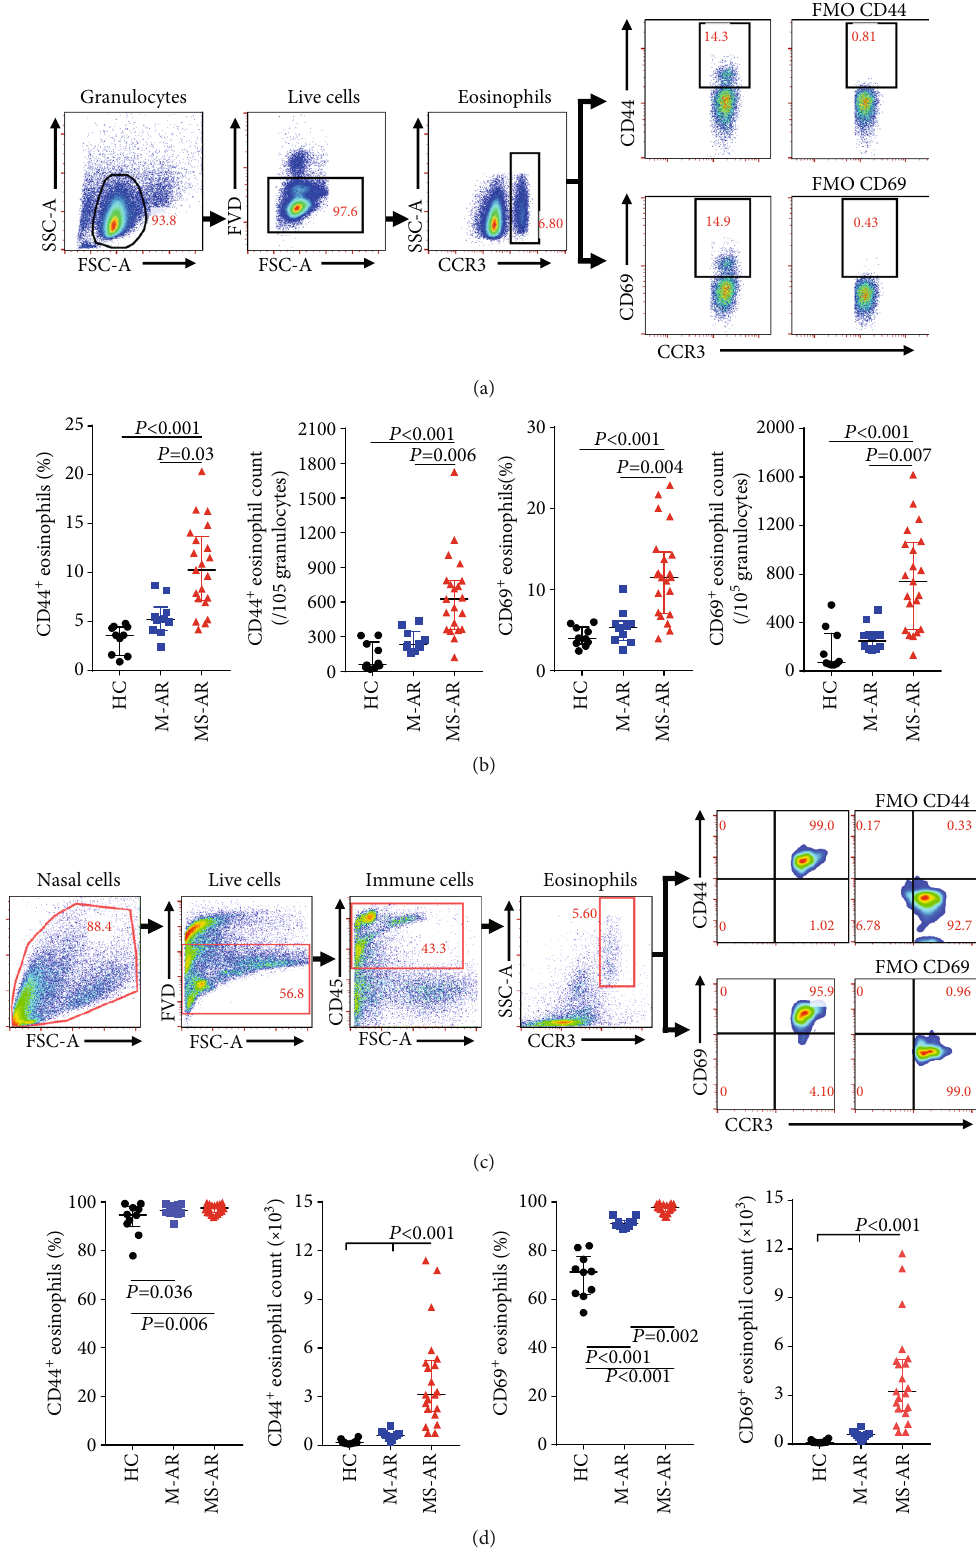
Figure 2: The numbers of activated eosinophils are increased in moderate-severe allergic rhinitis. Gating strategies used to characterize the activated status of eosinophils in the peripheral blood (a) and nose (c). Percentages and absolute numbers of CD44- and CD69-expressing eosinophils in the peripheral blood (b) and nose (d). Data are presented as median with interquartile range. HC: healthy controls; M-AR: mild allergic rhinitis; MS-AR: moderate-severe allergic rhinitis; FMO: fl uorescence minus one